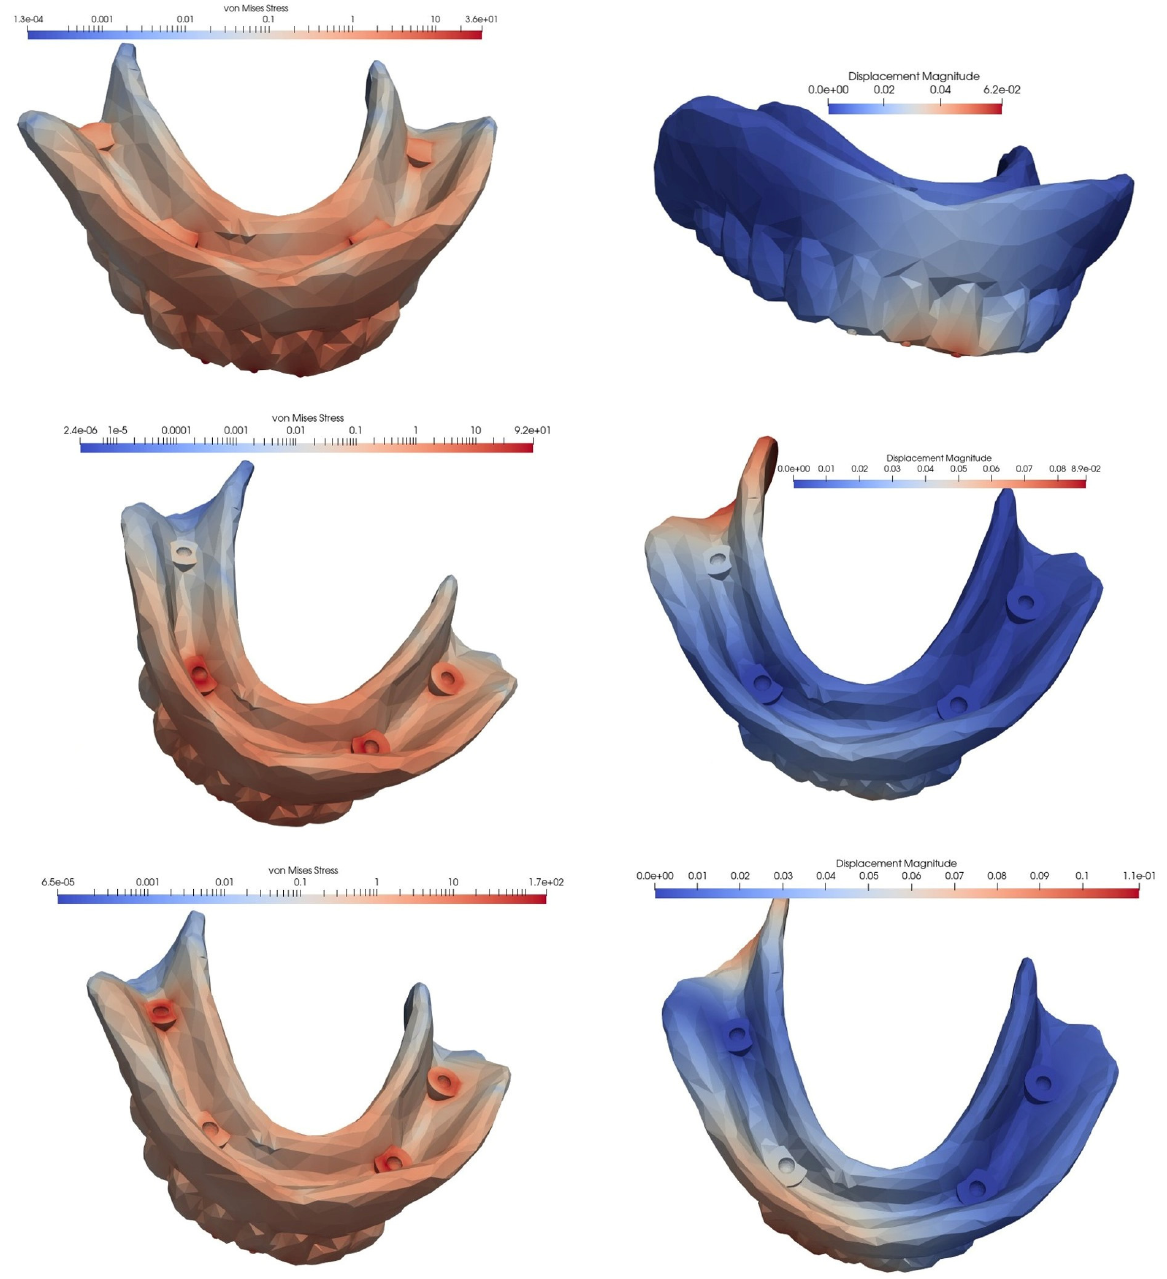
Figure 8. The von Mises stresses and displacements generated by the frontal loading of an overden- ture on four MDIs, two of which are inserted in the canine area and two in the molar area ( top ), com- pared to the situations of loss of an implant in the molar area ( middle ) or the canine area ( bottom ).